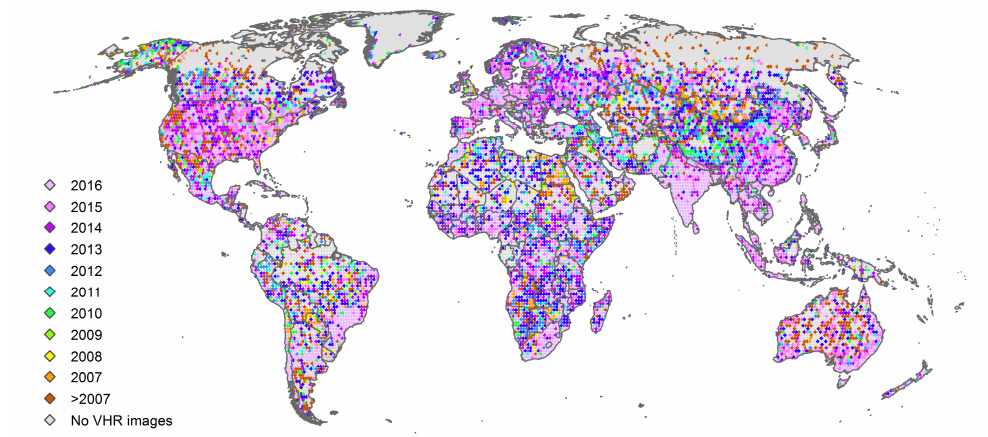
Figure 3. The dates of the most recent VHR satellite imagery (<5 m resolution) available in Google Earth as of January 2017 (Software: Esri ® ArcMap™ 10.1).